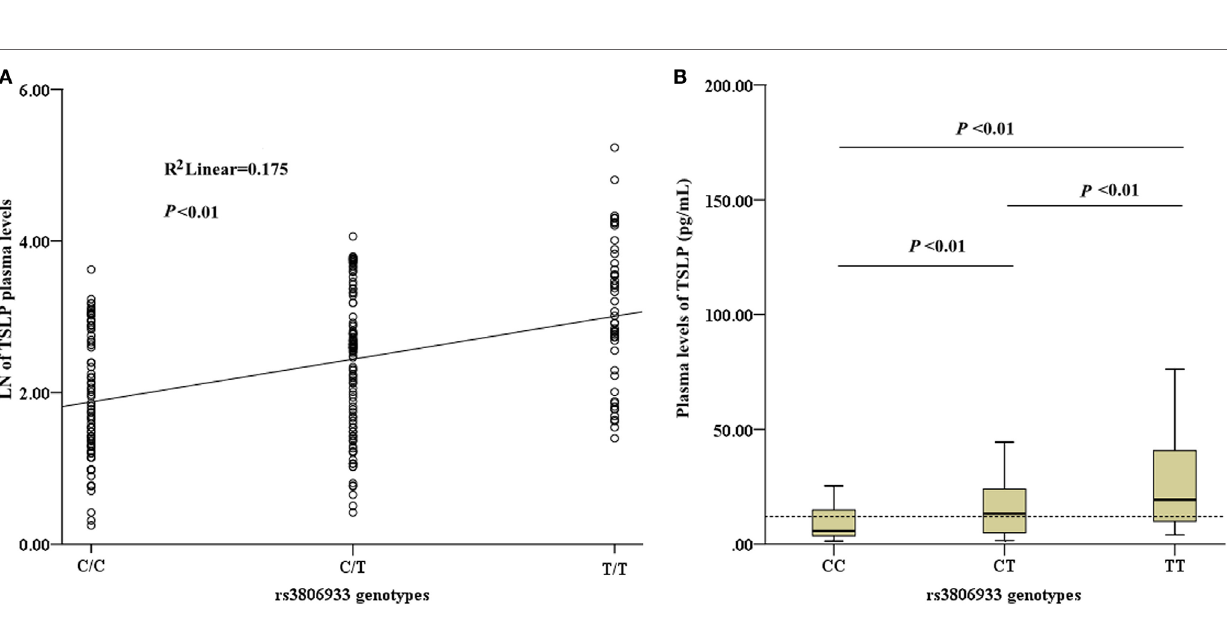
FigUre 3 | Analysis of circulating thymic stromal lymphopoietin (TSLP) level. (a) Association analysis between the circulating level of TSLP and the rs3806933 genotypes in a linear regression model; (B) Comparisons among every pair of the three genotypes, via the ANOVA test. The terminology of P < 0.01 indicates statistical significance. A broken line indicates the median value of 12.03 pg/mL of TSLP levels that were detectable in coronary artery disease patients. The extremes in the Box Graph analysis of panel (B) have been removed to avoid the interference.